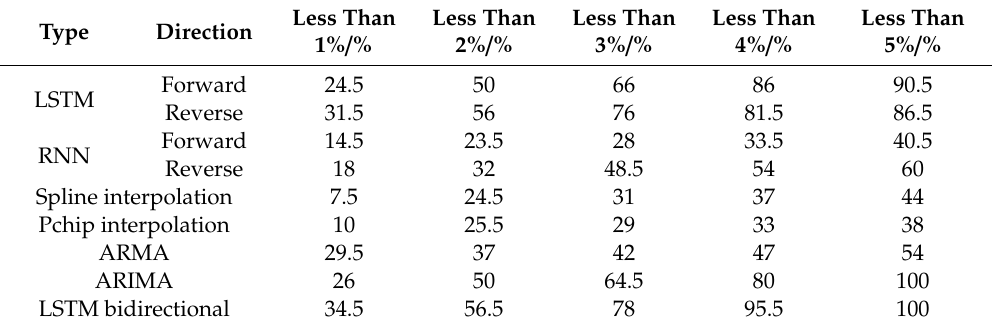
Table 6. Comparison of error distributions.